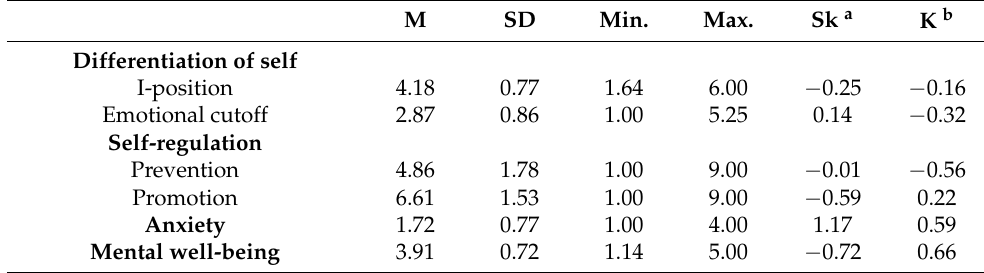
Table 1. Distribution and Descriptive Statistics of the Study Variables (N =